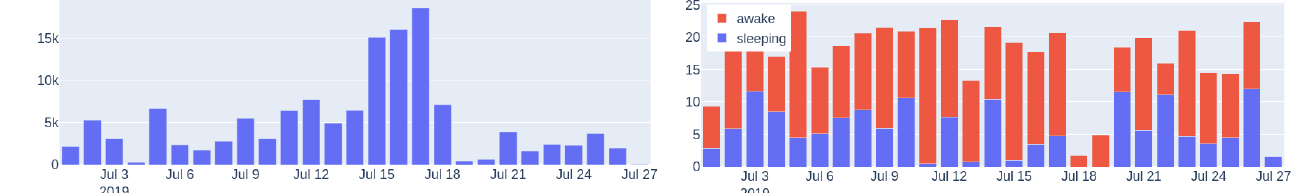
Figure 7. Steps per day ( left ) and hours spent sleeping and awake ( right ) during one month of a subject’s